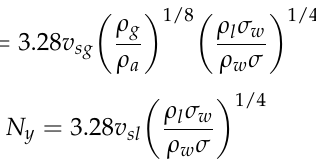
Figure 5. Application of Duns–Ros flow pattern discrimination formula.